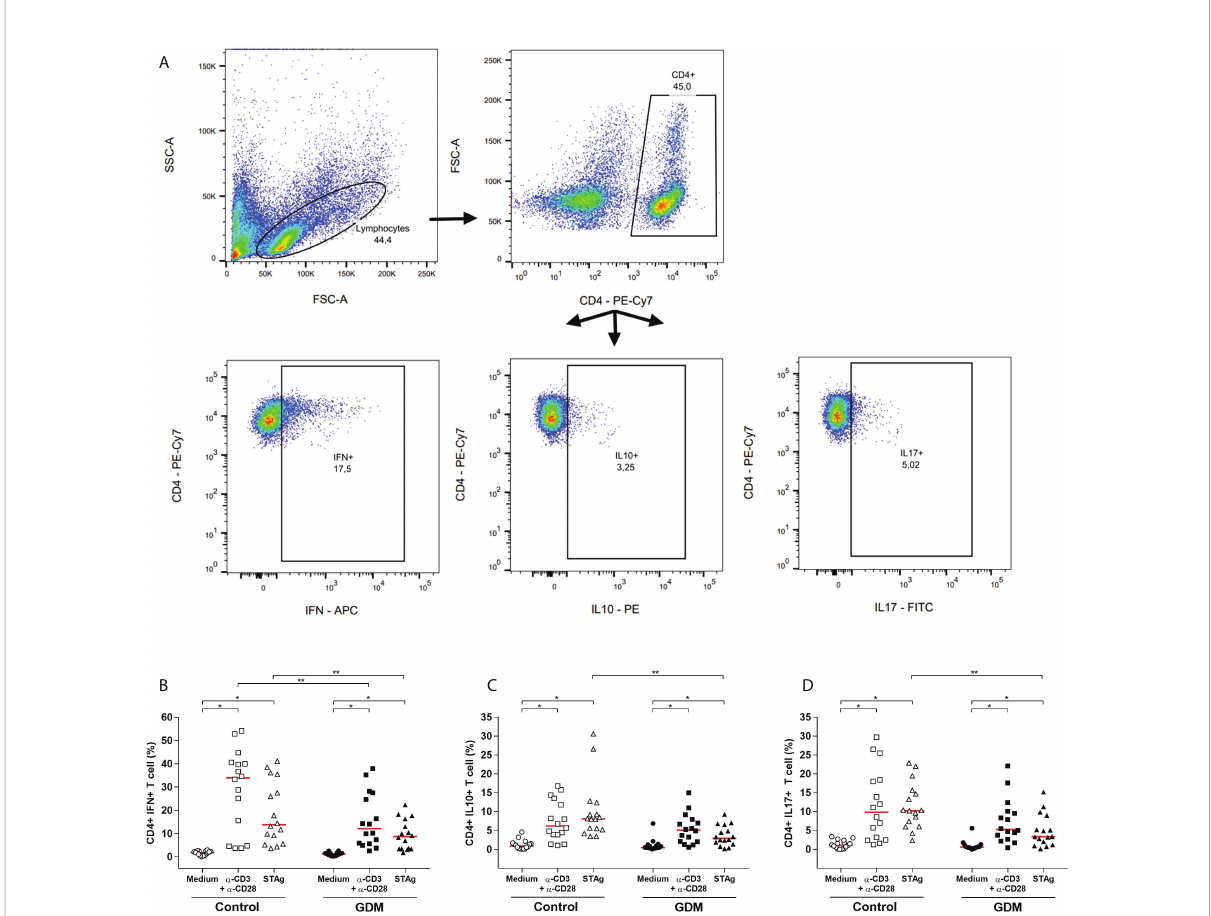
FIGURE 5 Intracellular production of cytokines by CD4 + T lymphocytes. (A) Gating strategy employed. Percentage of CD4 + T cells producing (B) IFN- g , (C) IL-10, (D) IL-17, which were acquired by fl ow cytometry of PBMC cells from 32 pregnant women (16 GDM and 16 controls) after 96 hours culture in three conditions (medium, polyclonal a -CD3/ a -CD28 stimulus and speci fi c STAg stimulus). The red line represents the median of the values. Statistically signi fi cant data, p<0.05 *Wilcoxon **Mann-Whitney. GDM, Gestational diabetes